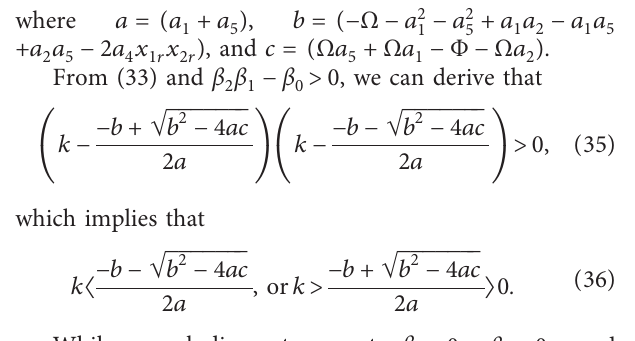
with respect to the state variable x 3